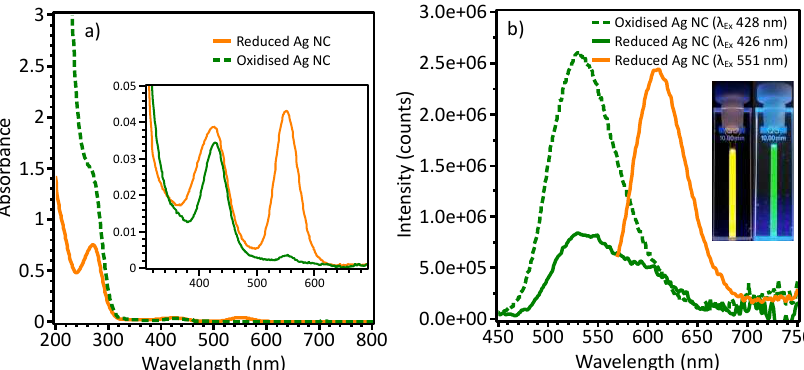
Figure 1. ( a ) UV-visible absorption spectra of un-oxidised (orange solid line) and oxidised (green dashed line) Ag NCs. ( b ) Emission spectra of un-oxidised (solid lines) and oxidised (dashed line) Ag NCs. Inset: Fresh, un-oxidised Ag NC had bright orange-yellow PL, and Ag NC after oxidation with H 2 O 2 had green